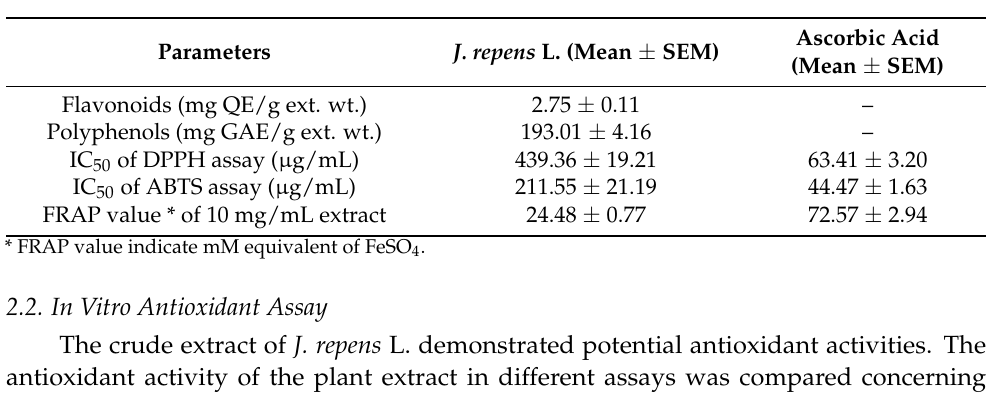
Table 1. Polyphenols, flavonoids and in vitro antioxidant capacity of J. repens L. Parameters J. repens L. (Mean ± SEM) Flavonoids (mg QE/g ext. wt.) 2.75 ± 0.11 Polyphenols (mg GAE/g ext. wt.) 193.01 ± 4.16 IC 50 of DPPH assay ( µ g/mL) 439.36 ± 19.21 63.41 ± 3.20 IC 50 of ABTS assay ( µ g/mL) 211.55 ± 21.19 44.47 ± 1.63 FRAP value * of 10 mg/mL extract 24.48 ±